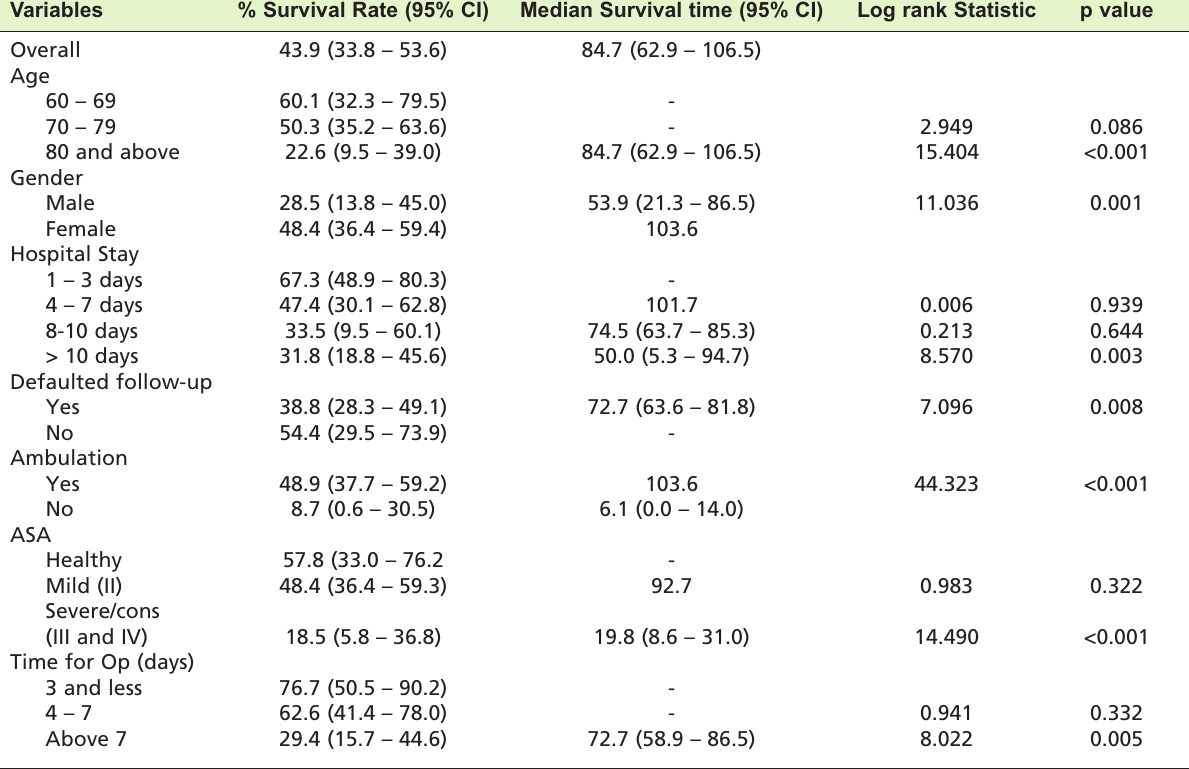
10-year survival rate and median survival time by demographics and clinical characteristics Table II: (Kaplan-Meier and log rank